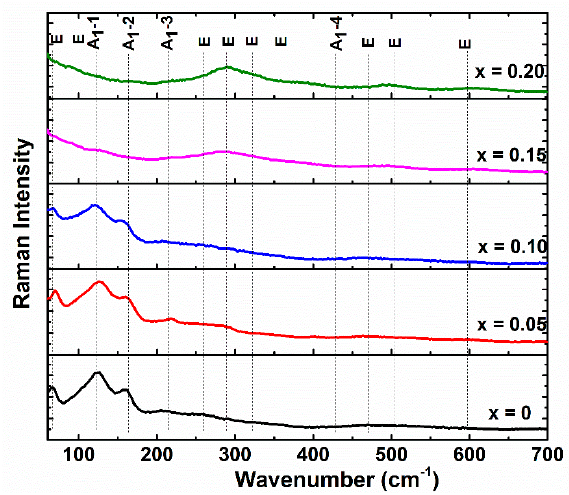
Figure 6. Typical Raman scattering spectra of Bi 1 − x Eu x FeO 3 calcined powders.